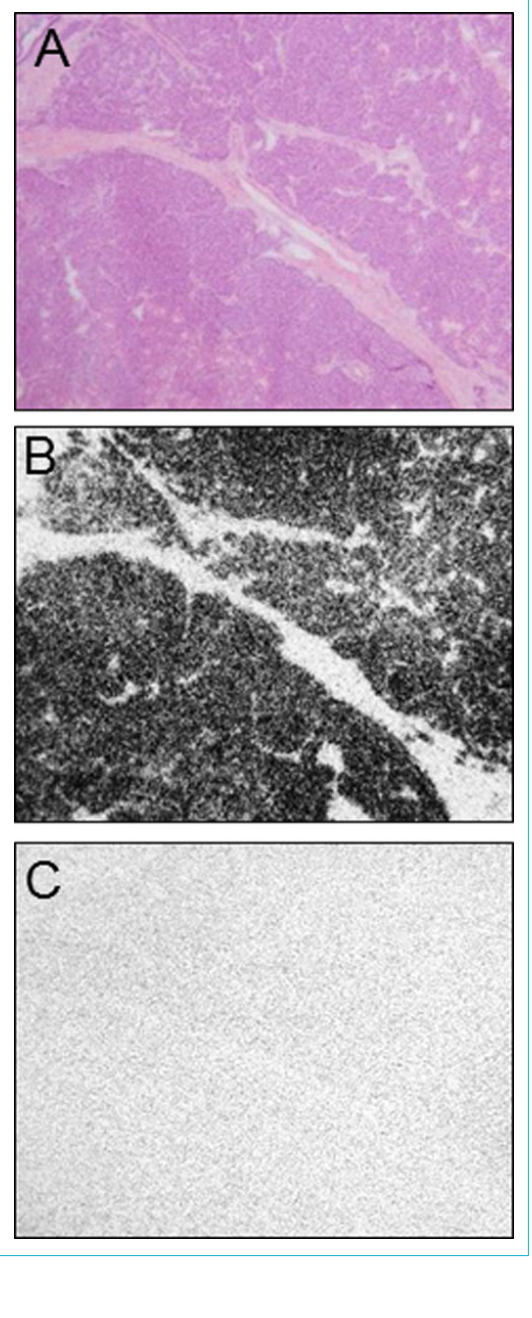
Figure 1: Autoradiography in a patient with a benign insulino- ma. A: H&E staining B: Autoradiography using 125 -I-GLP-1 (7-36) amide: homogenous and increased expression of GLP-1 recep- tors. C: Aujtoradiography showing non-specific binding of 125 -I- GLP-1 (7-36) amide in the presence of 100nm GLP-1 (7-36) amide.This figure was kindly provided by Beatrice Waser and Jean Claude Reubi.